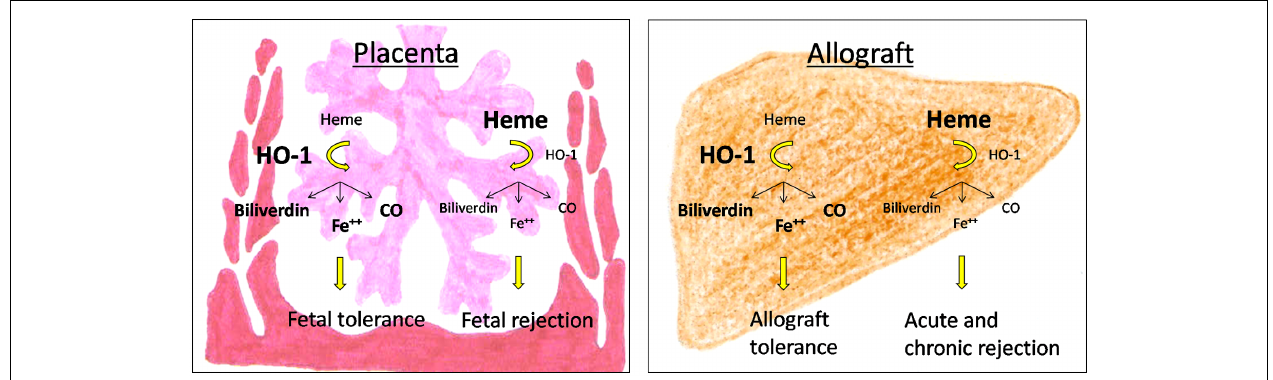
FIGURE 2 | Consequences of HO-1-deficiency for pregnancy outcome and allograft acceptance.